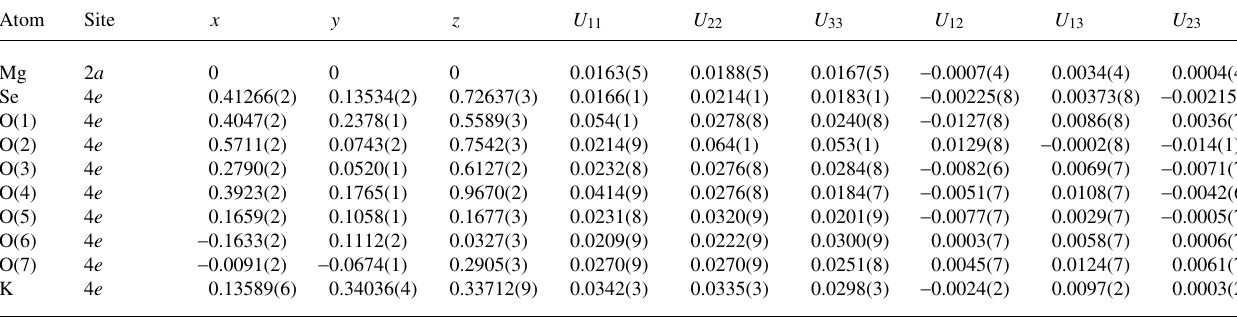
Table 3. Atomic coordinates and displacement parameters (in Å 2 ) .